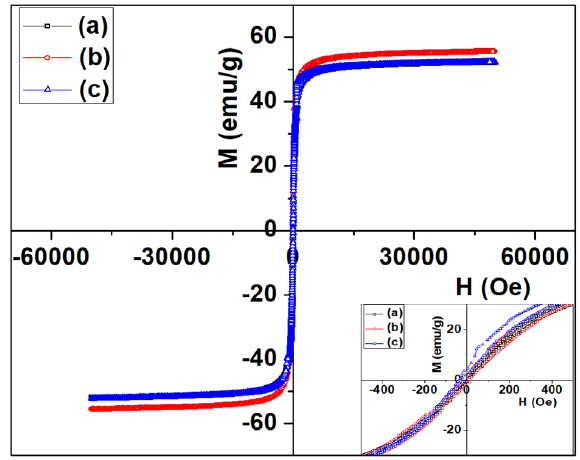
Fig. 9 Magnetic hysteresis curves of a Fe 3 O 4 , b PANI-coated Fe 3 O 4 , and c polypyrrole-coated